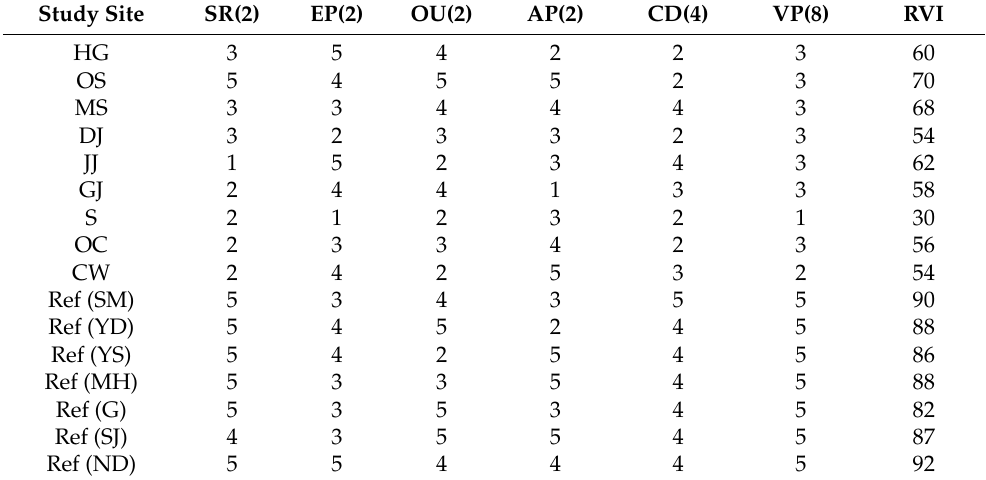
Table 2. The result evaluated the restoration effect based on the riparian vegetation for nine restored streams. Abbreviated river name is the same as in Table 1. In the vegetation indices, the numbers in parentheses indicate the weighted values. SR: Species richness, EP: The ratio of exotic plant, OU: The ratio of obligate upland plant, AP: The ratio of annual plants, CD: Community diversity, VP: Vegetation profile, RVI: Riparian Vegetation Index. 5: very good, 4: good, 3: medium, 2: poor, 1: very